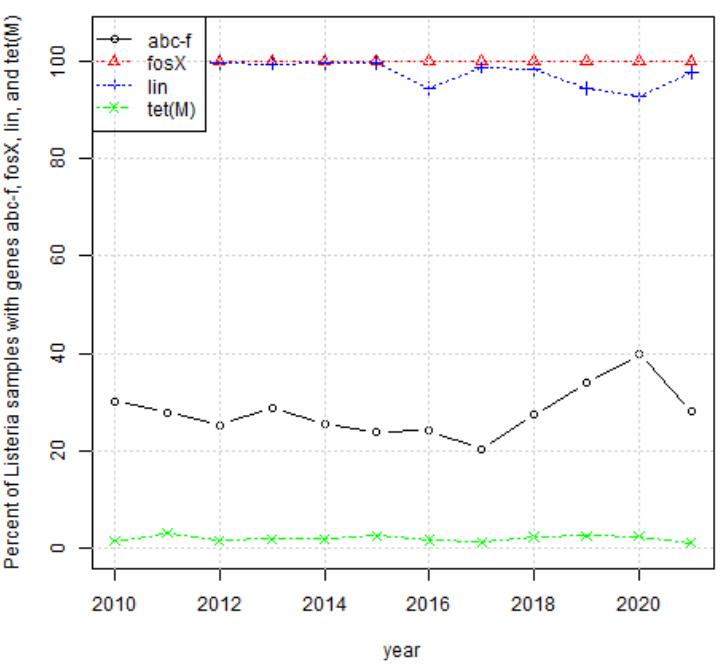
Figure 7. Percentage of L. monocytogenes samples per year with genes fosX , lin, abc-f, and tet(M) . Table 5. Biological functions of highly occurring AMR